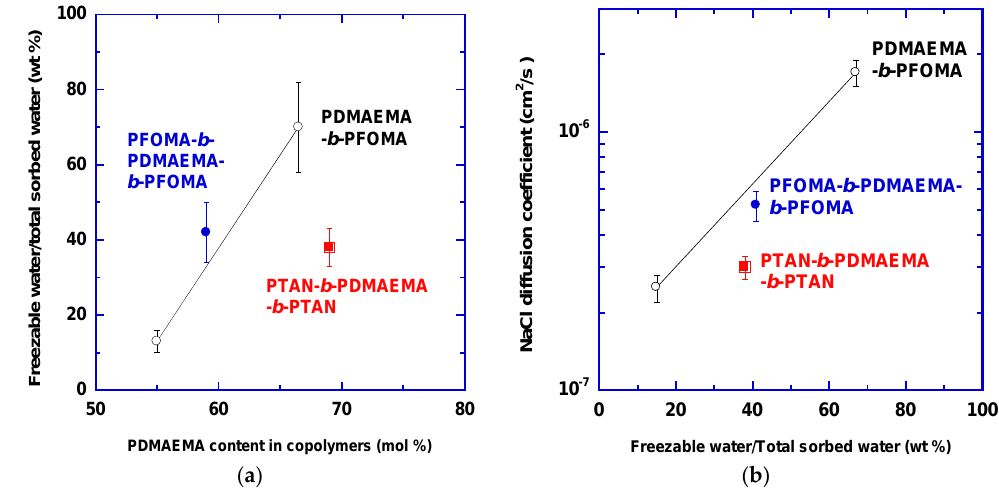
Figure 5. ( a ) Effect of PDMAEMA content on percentage of freezing water and ( b ) the effect of the percent freezing water on the NaCl diffusion coefficient in block copolymers at 25 °C. Adapted from [19].